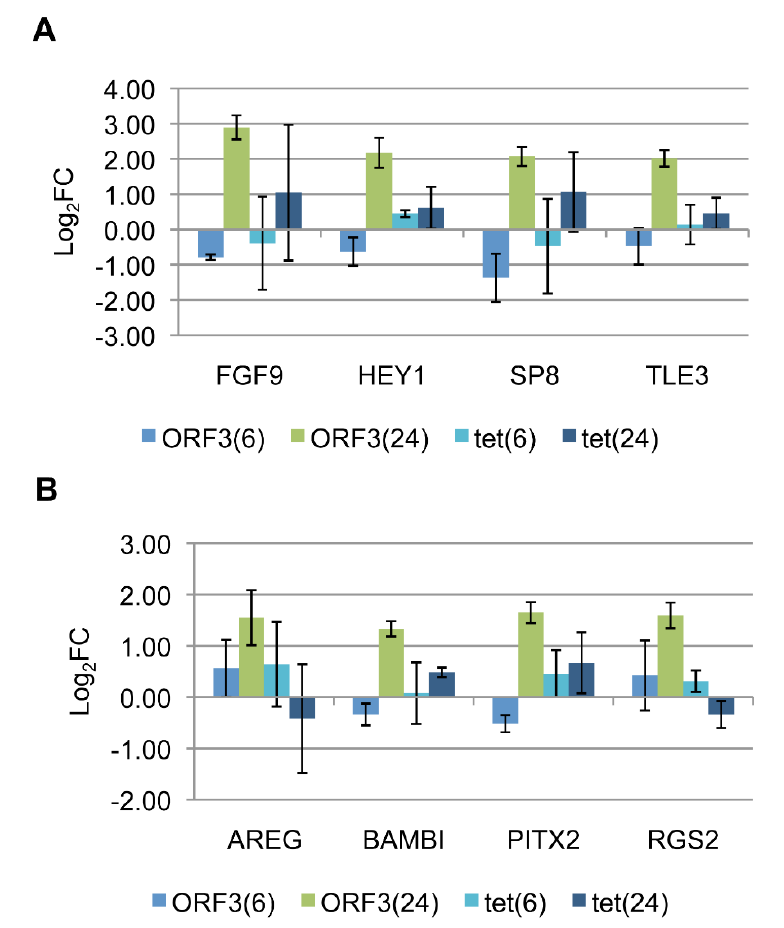
Figure 3. Validation of select E4-ORF3 targets from ( A ) cluster 1 or ( B ) cluster 2 by RT-qPCR with relative quantification. Bars represent Log 2 fold expression change in dox-treated Tet-E4-ORF3 or U2OS-Tet cells relative to mock treated Tet-E4-ORF3 or U2OS-Tet cells, normalized to GAPDH at 6 and 24 hours post-induction. Error bars = S.D., n =